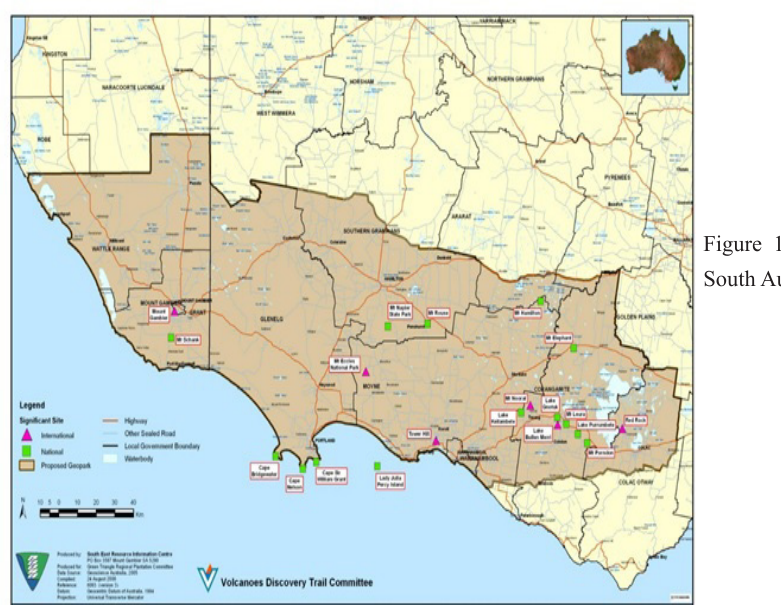
Figure 1. Kanawinka UNESCO